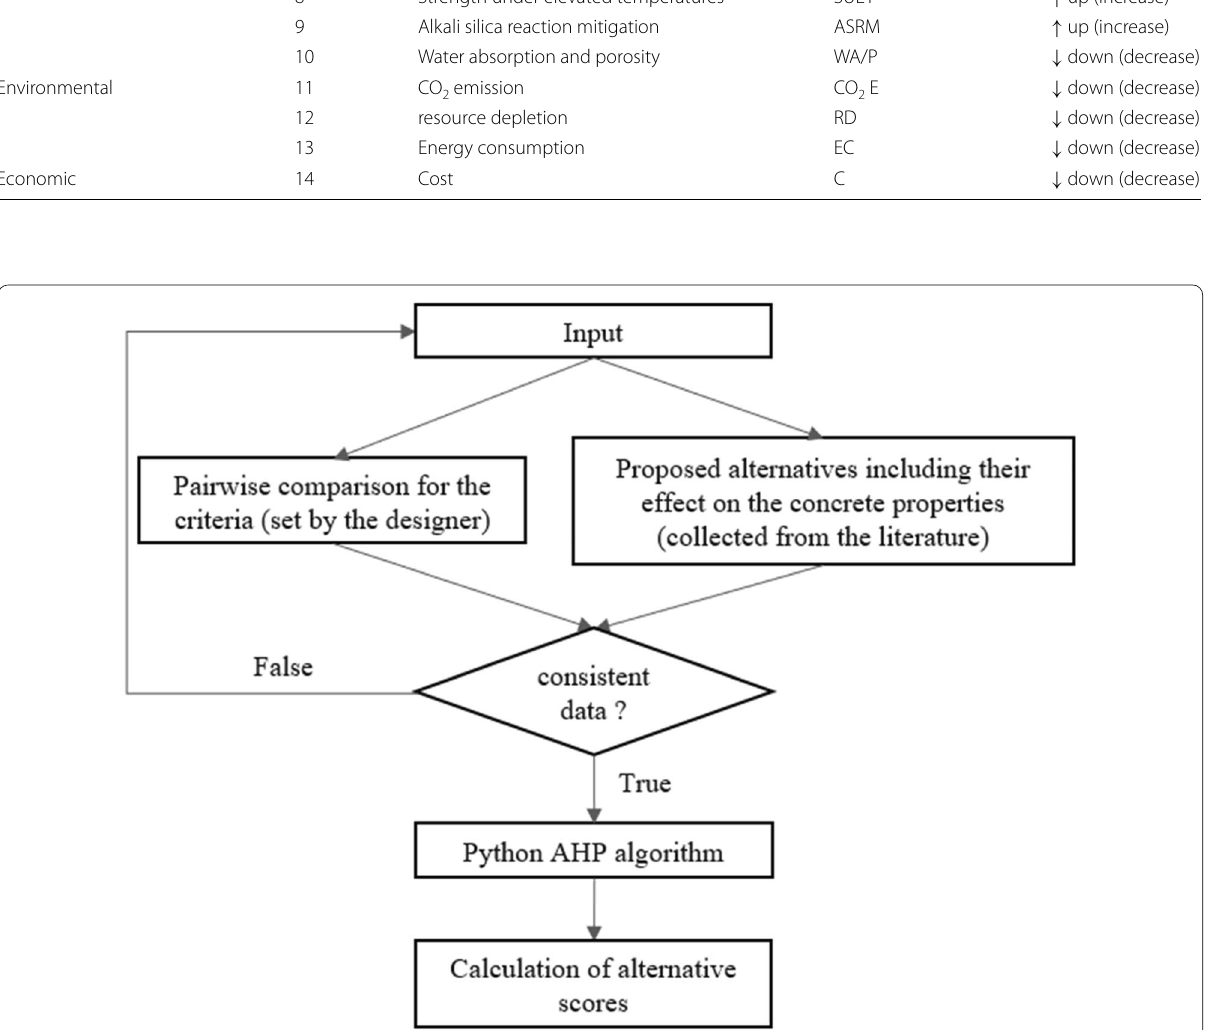
Fig. 2 Flowchart of the